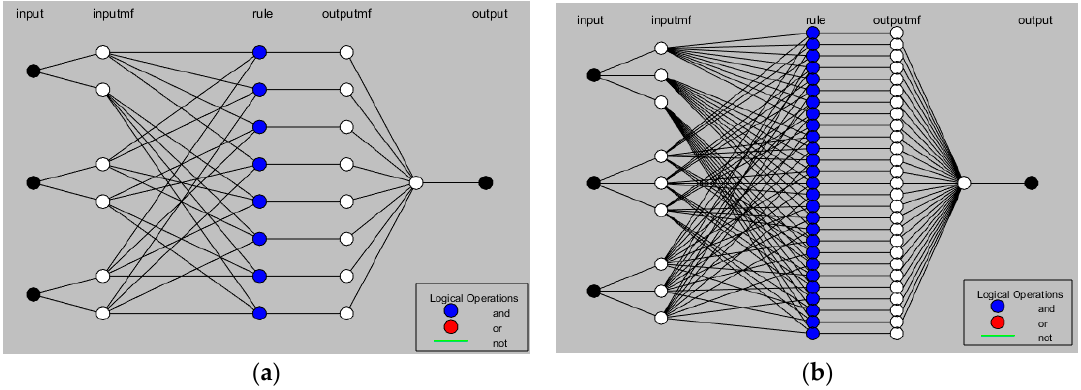
Figure 6. ANFIS network with two membership functions (MFs) ( a ) and three MFs ( b ).